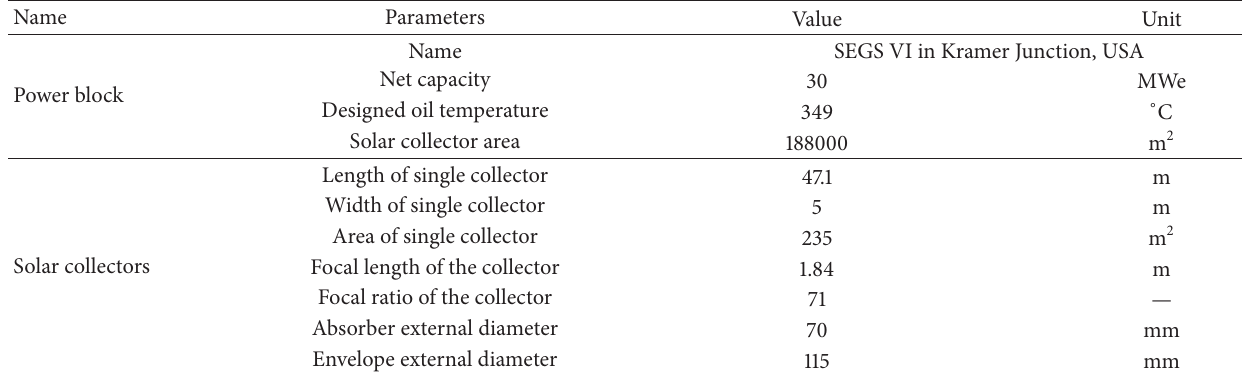
Table 1: The system main parameters of the SEGS VI power plant